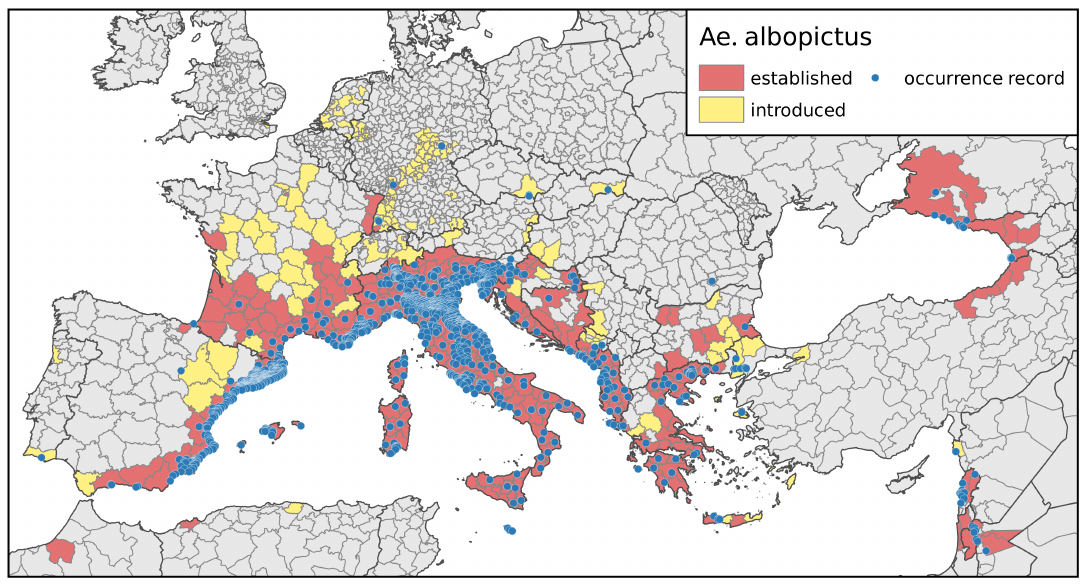
Figure 1. European distribution of Aedes albopictus as of January 2018. Blue dots: high-precision occurrence records derived from the literature and used for modelling ( n = 1336). Red and yellow areas: administrative units with established populations and introduced specimens, respectively, according to the European Centre for Disease Prevention and Control [38]. Areas are level-3 administrational units following the nomenclature des unit é s territoriales statistiques (nomenclature of territorial units for statistics, NUTS) as used by the European Union. For Germany, this corresponds to the district (Kreis)